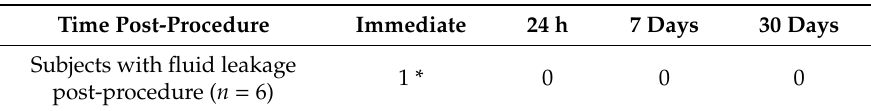
Table 2. Blood patch